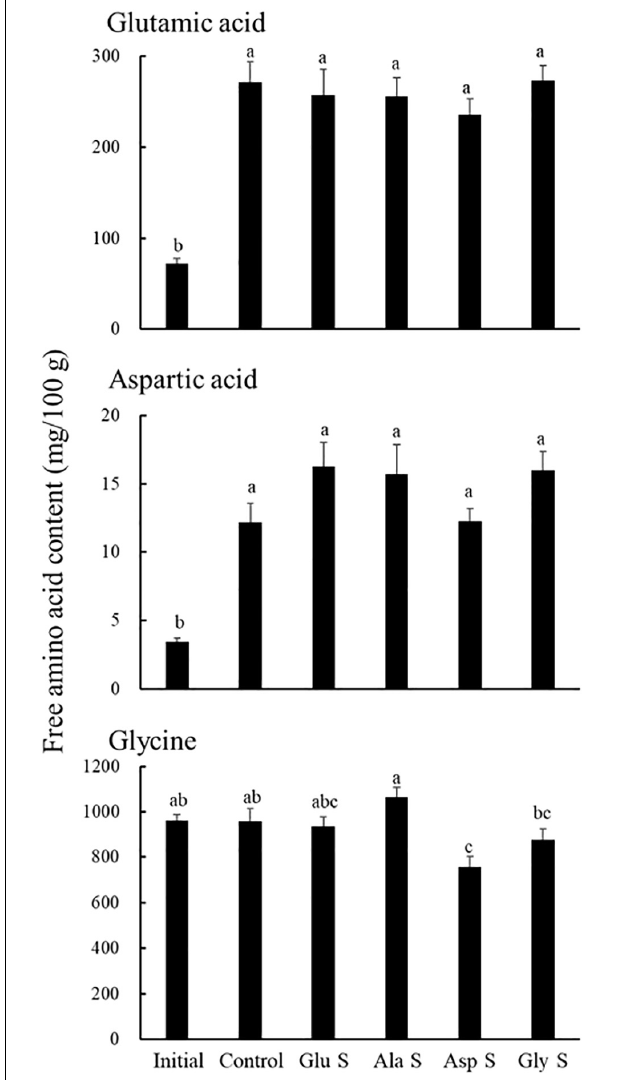
FIGURE 2 | Glutamic acid, aspartic acid and glycine contents in Mesocentrotus nudus gonads of the initial group and each treatment group at the end of the experiment (mean ± SE) ( n = 16). An explanation of Initial, Control, Glu S, Ala S, Asp S, and Gly S is provided in Table 2 . Lower-case letters indicate significant differences among groups ( p < 0.05 by Tukey’s